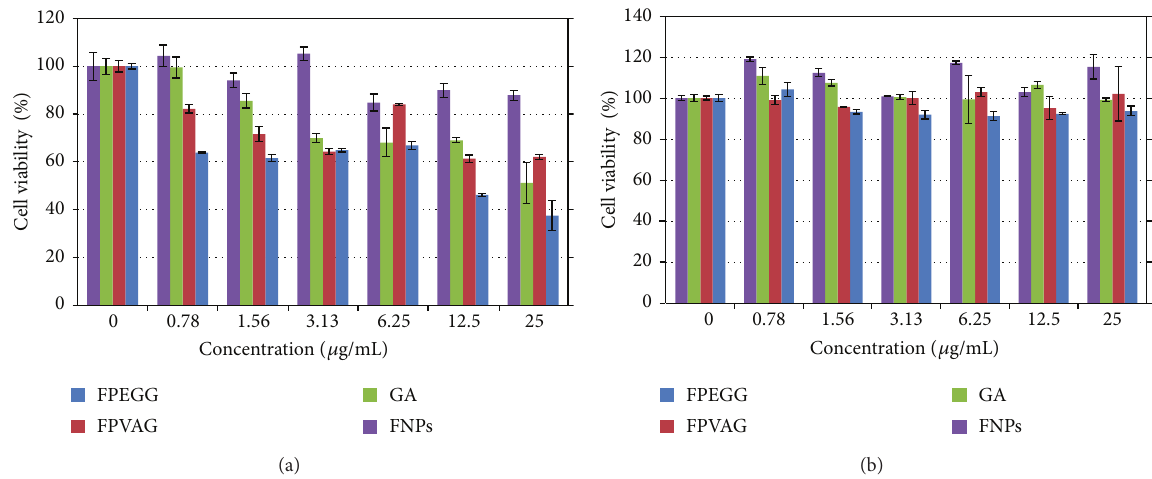
Figure 8: Cell viability assays of (a) MCF-7 cell lines and (b) MRC-5 cells and anticancer activity of FNPs, GA, FPEGG, and FPVAG nanocomposites, respectively, after 72 hours of treatment. FNPs: iron oxide nanoparticles; GA: pure gallic acid; FPEGG: iron oxide coated with polyethylene glycol and gallic acid; FPVAG: iron oxide coated with polyvinyl alcohol and gallic